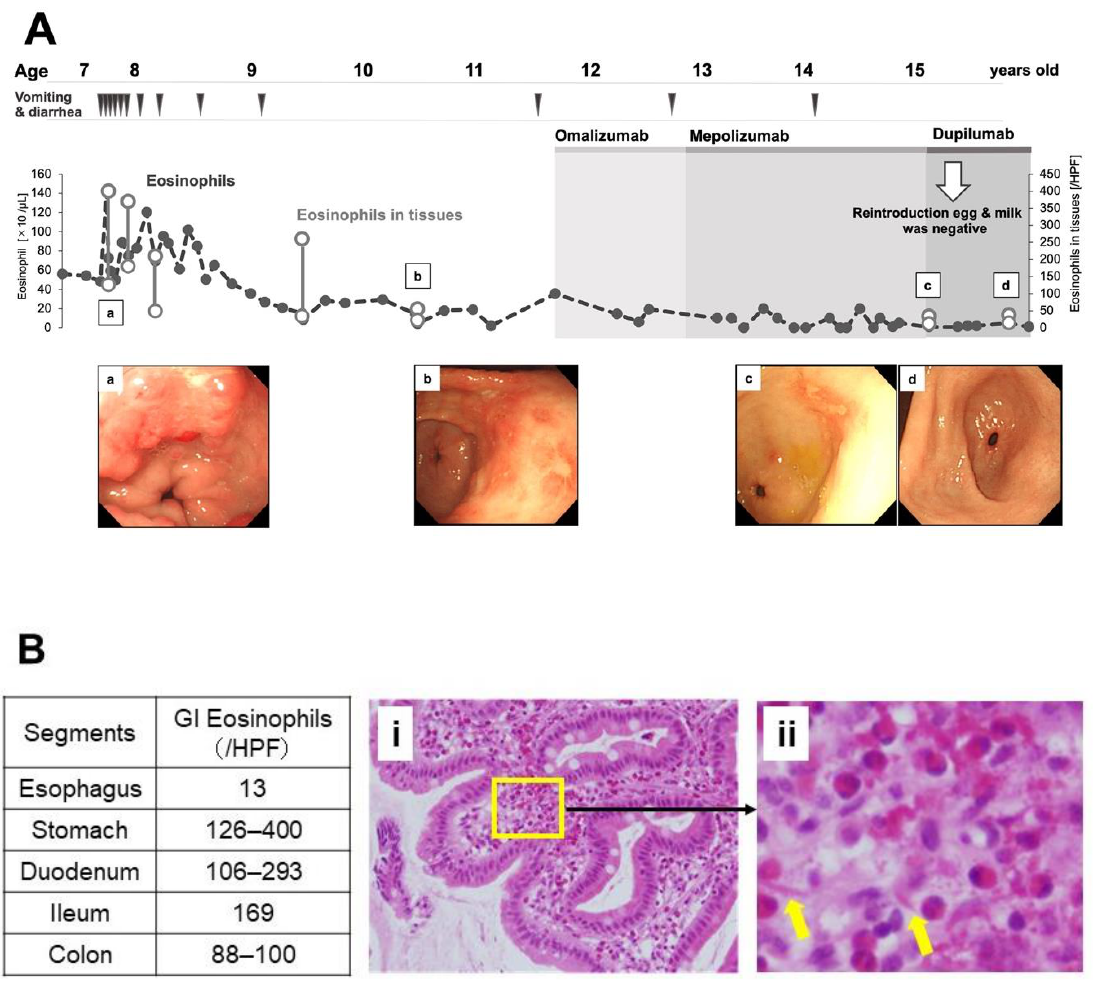
Figure 2. Clinical course of the patient with non-EoE EGID. ( A ) Peripheral blood (line chart) and gastric (vertical line) eosinophil counts and endoscopic findings of a patient’s stomach (a–d) are shown in chronological order. ( B ) Histopathologic analysis of the patients. Gastrointestinal eosinophil counts in each segment are tabulated. ( i ) Histological findings of the duodenum using hematoxylin and eosin staining (optical magnification 200 × ). ( ii ) The inset shows a magnified view of the original image. The arrows point to Charcot–Leyden crystals. HPF, high-power field; GI,